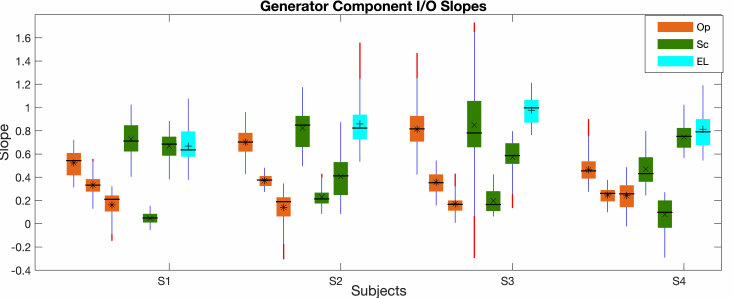
Figure 5. Boxplot of the I / O gen slopes at low, mid, and high L 2 s (three orange and green bars show the Op and Sc paradigms, respectively; the cyan bars show the mid-level values in EL paradigm) across frequency. The central horizontal line, and the bottom and top edges of the boxes indicate the median, 25th and 75th percentiles, respectively. The averages of individual bars are indicated by the ∗ , × , + symbols (for the Op, Sc, and EL paradigms, respectively) inside the boxes. The whiskers extend to the most extreme data points and outliers are plotted using red dots. The subjects IDs (S1–S4) are indicated on the